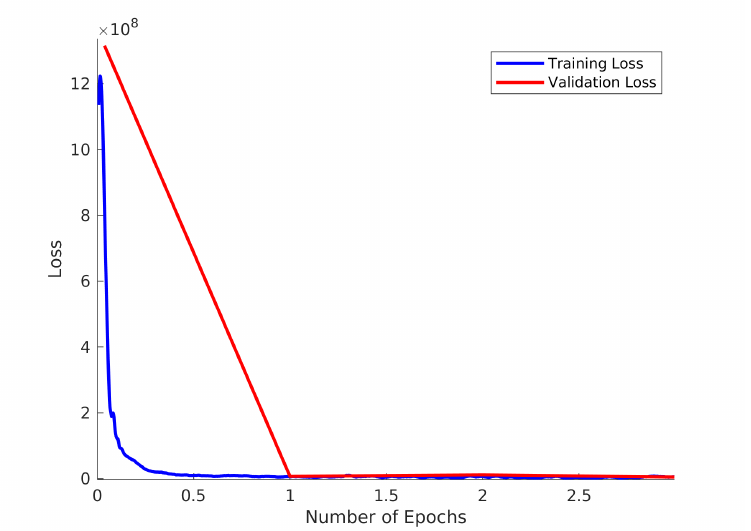
Figure 2. Training and Validation loss for α =